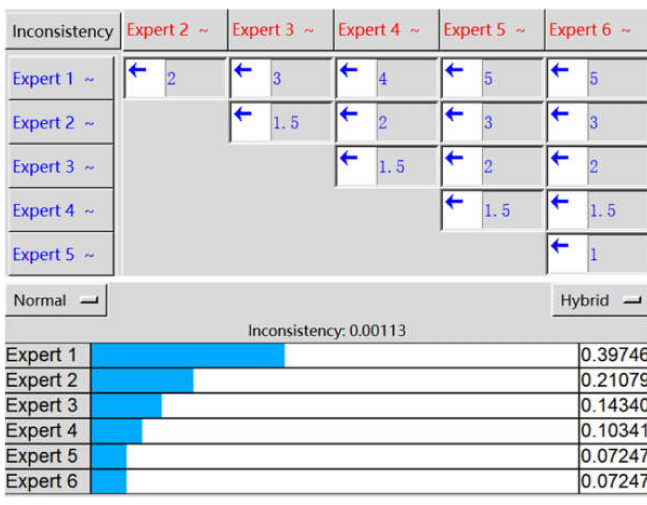
Figure 6. The AHP procedure in “Super